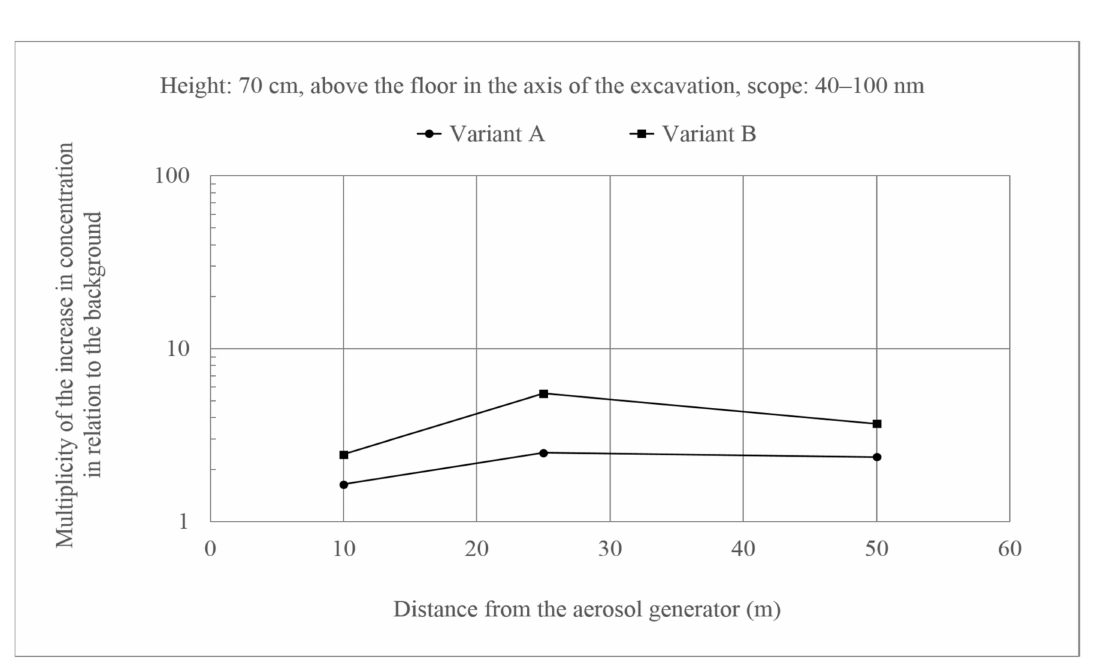
Figure 8. Increase in the concentration of aerosols of the size 40–100 nm at a height of 70 cm above the floor in the axis of the excavation in relation to the background. Generator capacity: 17 cm 3 of solution/min.